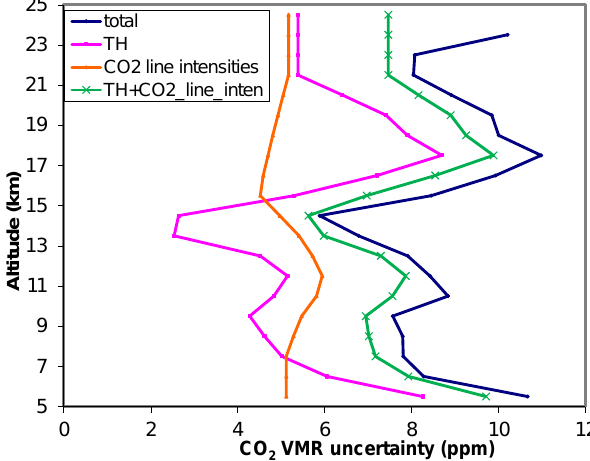
Figure 7. Overall error budget for ACE including TH-related con-